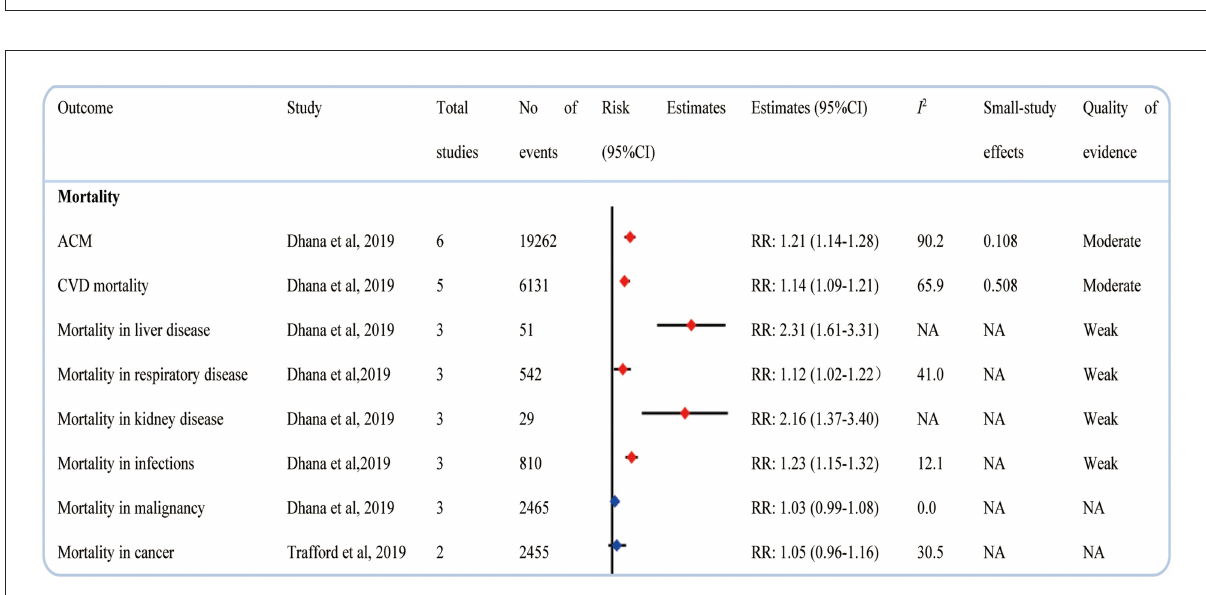
FIGURE3 Associations between psoriasis and mortality.